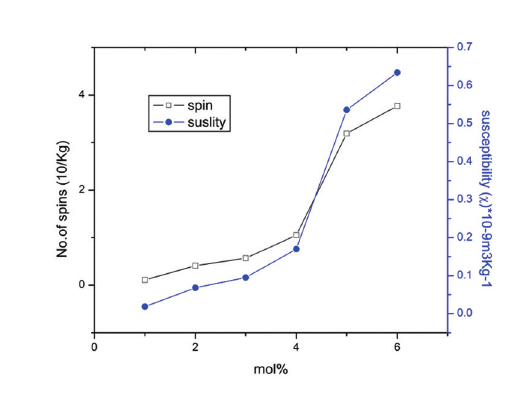
Figure 11: Variation of number of spins & susceptibility participating in PVC films containing Mn 2+ ions.